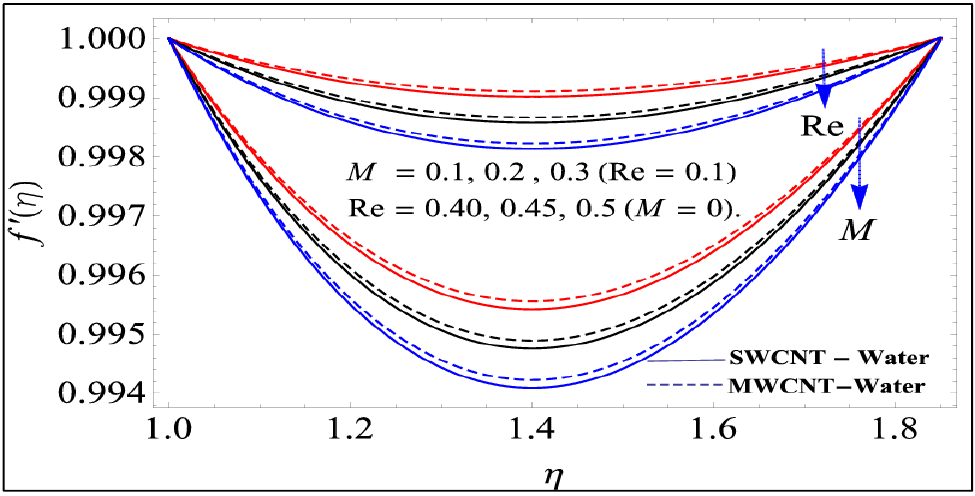
Figure 6. Impact of the & Re M on the velocity field.